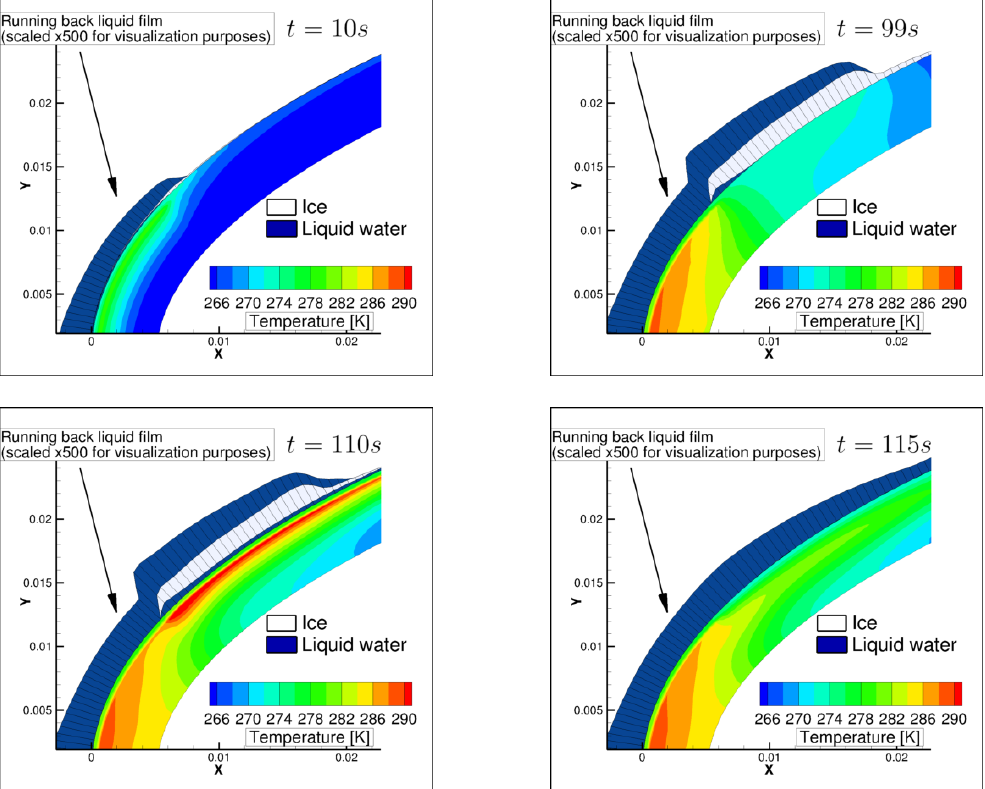
Figure 15. Temperature field in the electrothermal system and unsteady ice accretion solution at different simulation times. ( Top left ): t = 10 s. ( Top right ): t = 99 s. ( Bottom left ): t = 110 s. ( Bottom right ): t = 115